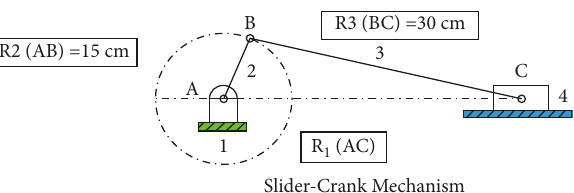
Figure 8: Buoyancy force free body diagram.